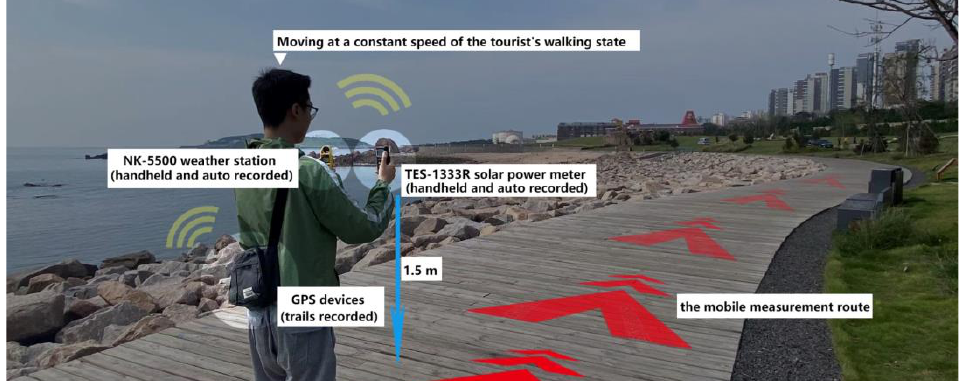
Figure 5. A researcher monitoring microclimate meteorological data in the Laoshan District Coastal Walkway.